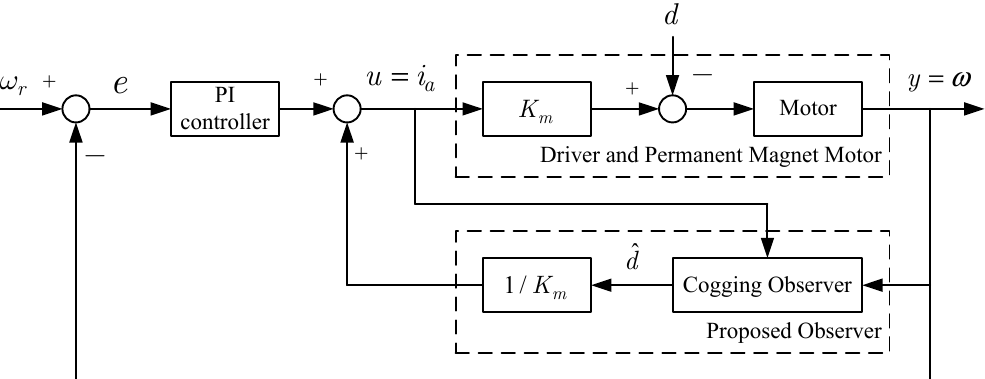
Figure 1. System